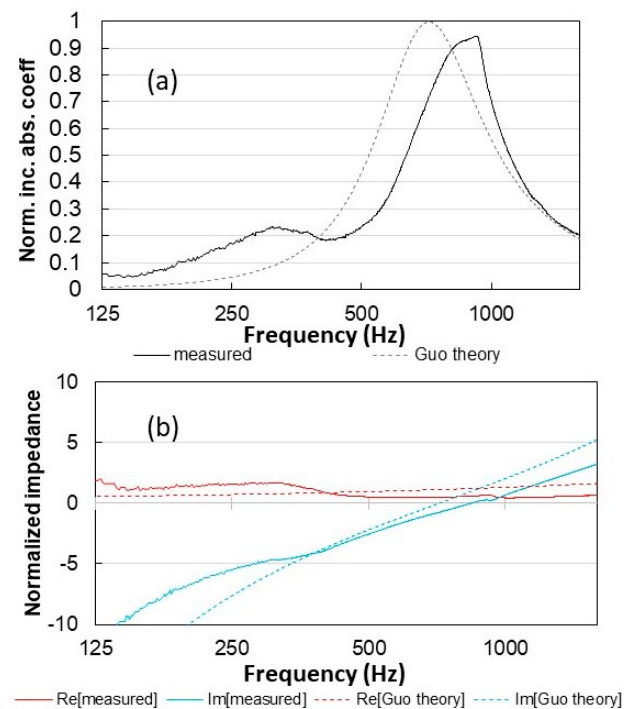
Figure 6. Comparison of the measured (solid line) and calculated (dashed line) values of the normal absorption coefficient ( a ) and specific impedance ( b ) of Specimen #1, with an air-back cavity of 25 mm depth.